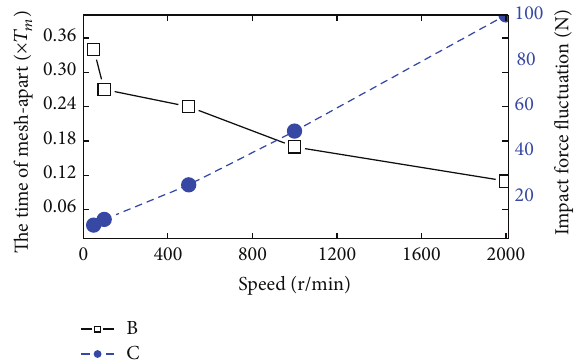
Figure 11: The effect of the input speed on gear vibroimpact